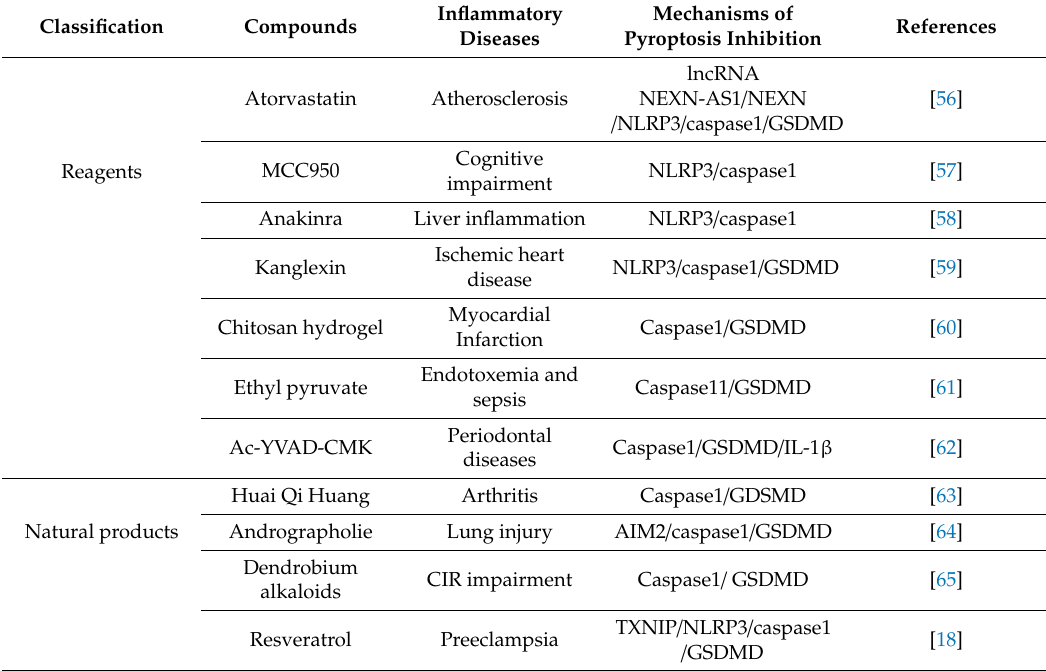
Table 1. Compounds inhibiting pyroptosis signal pathway to treat inflammatory